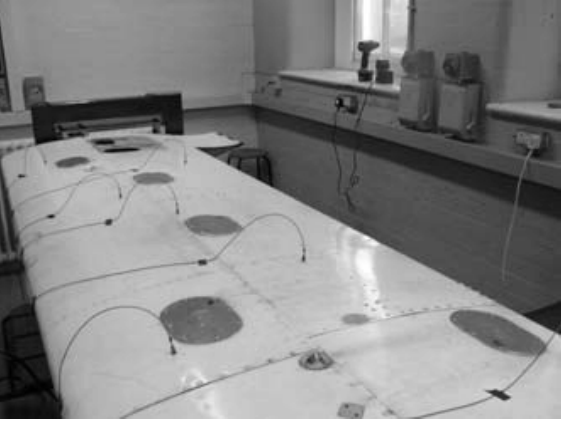
Fig. 1. Piper Tomahawk wing with five removable inspection